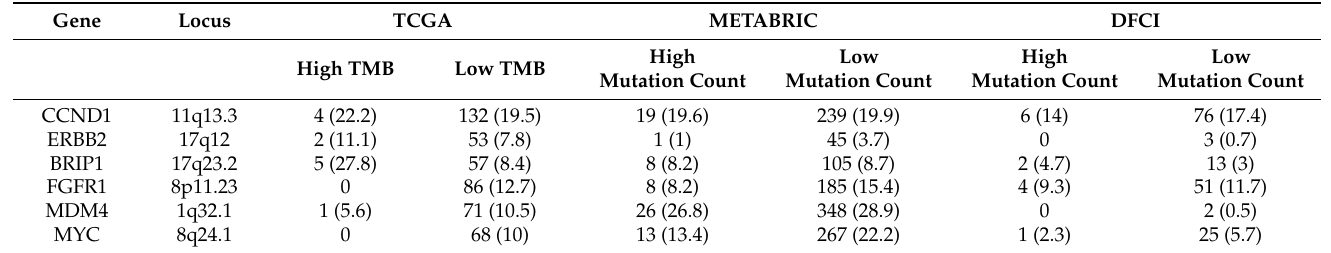
Figure 3. Prevalence of Aneuploidy Score (AS) of above or below 4 in luminal breast cancers according to TMB (Fisher’s exact test p = 0.39). High TMB group: >10 mutations/MB, low TMB group: ≤ 10 mutation/MB. Data are from TCGA. TMB—tumor mutation burden. Table 3. Amplifications commonly observed in the three series according to TMB/mutation count groups. In parentheses are